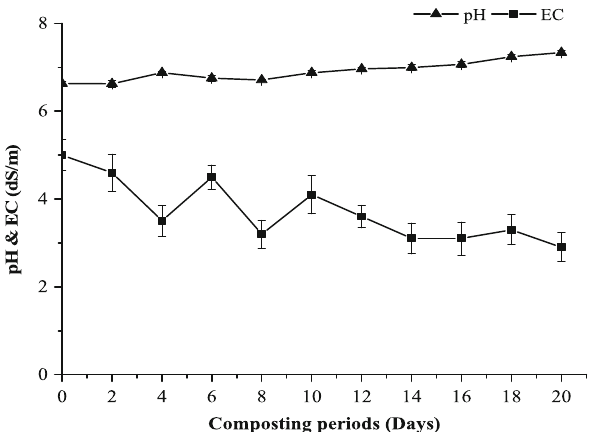
Fig. 4 VS% variations during the composting period Table 2 Total metal concentrations during composting period (mg/ kg dry